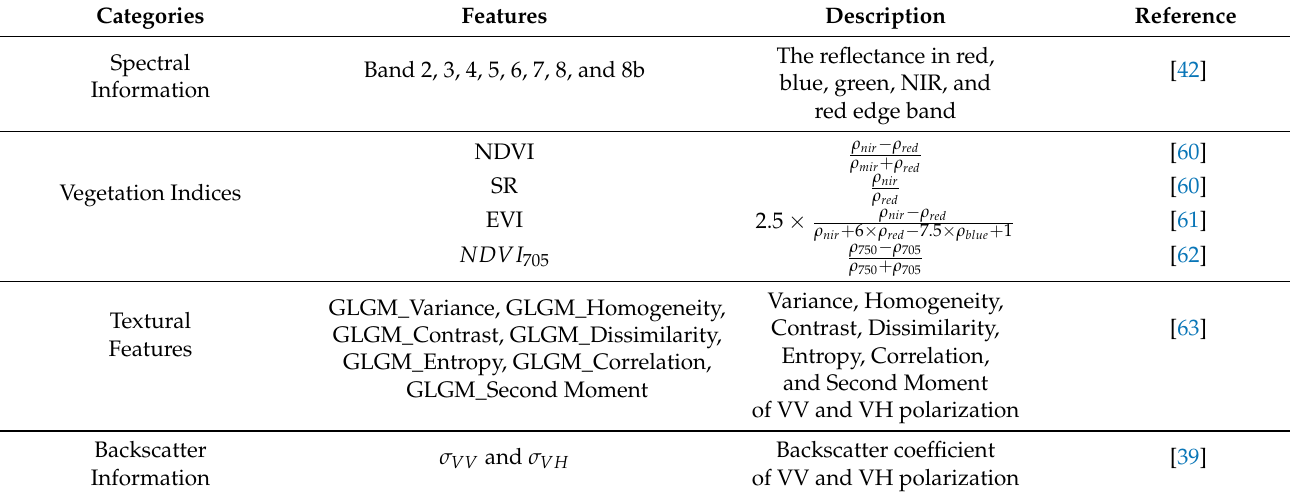
Table 4. Description of features extracted from Sentinel-1 and 2